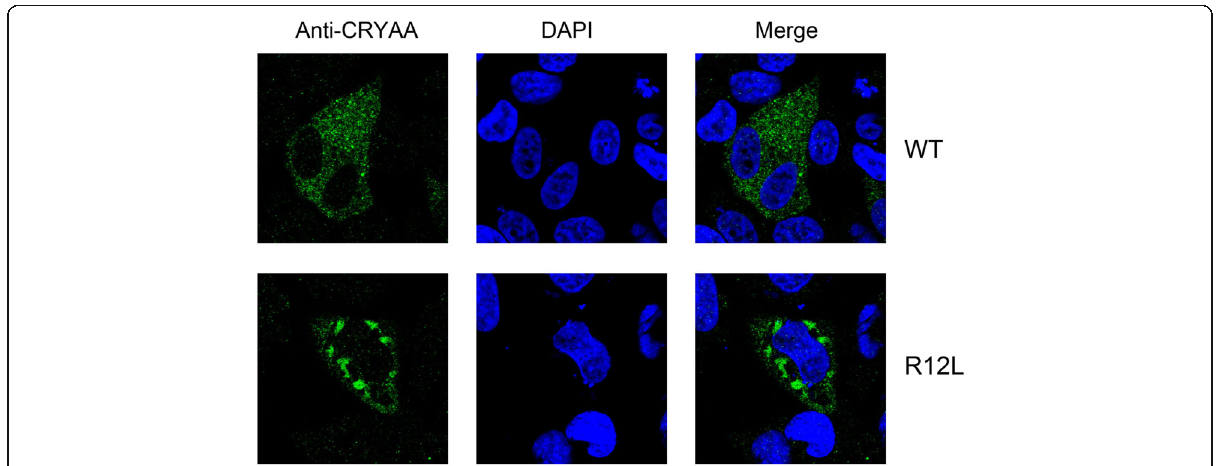
Fig. 6 Localization of wild-type and R12L mutated α A-crystallin proteins. Photomicrographs show the distribution of immunoreactive α A-crystallin (green) and DAPI-stained nuclei (blue) in HeLa cells. Both wild-type CRYAA and mutated R12L-CRYAA proteins were predominantly localized in the cytoplasm. Cells transfected with wild-type CRYAA showed a homogenous distribution of the protein in the cytoplasm and there was little or no aggregation in the cells. In contrast, the cells transfected with the mutant R12L-CRYAA showed significant intracellular aggregation in a number of